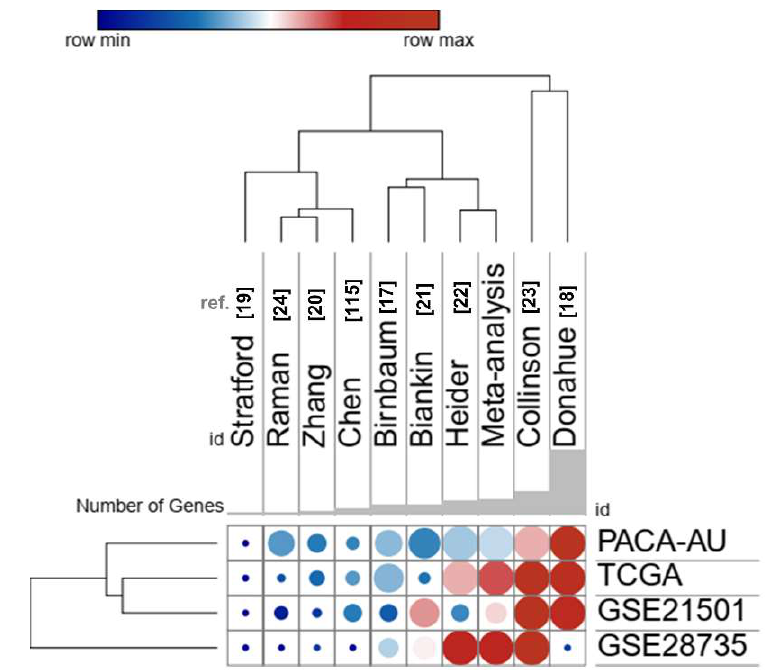
Figure 8. Performance of expression profile from the 39 secretome genes as potential pancreatic ductal adenocarcinoma (PDAC) biomarkers compared to nine previously gene signatures proposed for PDAC [17–24,115]. The color of the circles in the heat scatter plot represents the agreement index, while the size of the circle is based on the log-rank p -value of the risk group separation based on the SurvExpress tool. Rows and columns were grouped based on the Euclidean distance between the agreement index values. Datasets of PDAC patients: PDAC-TCGA [112], PACA-AU—ICGC [113],